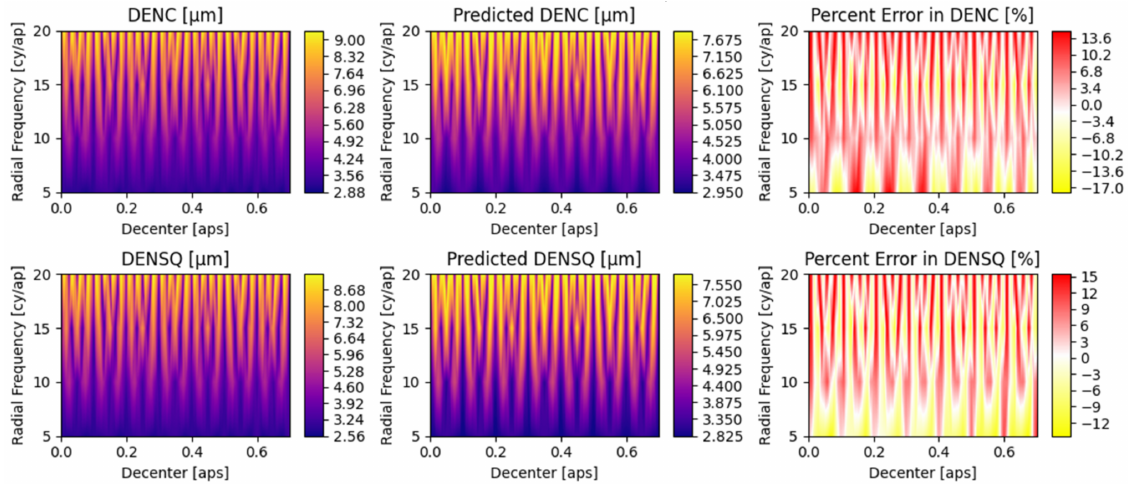
Figure A2. Decenter versus radial frequency. ( κ = ω = η = ζ = 0, σ = 0.05, θ = 15 ◦ ).